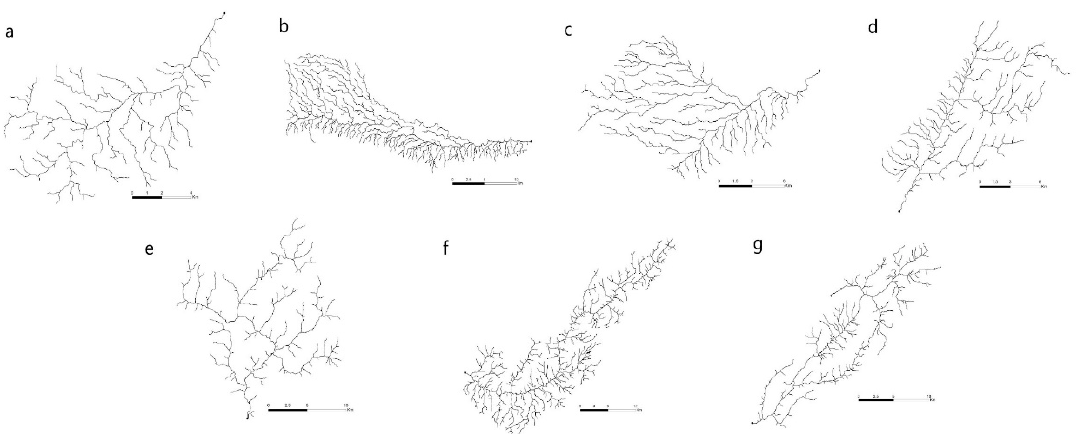
Figure 3. Example of identified drainage network patterns: ( a ) dendritic, ( b ) pinnate, ( c ) parallel, ( d ) trellis, ( e ) rectangular, ( f ) herringbone, ( g ) barbed.